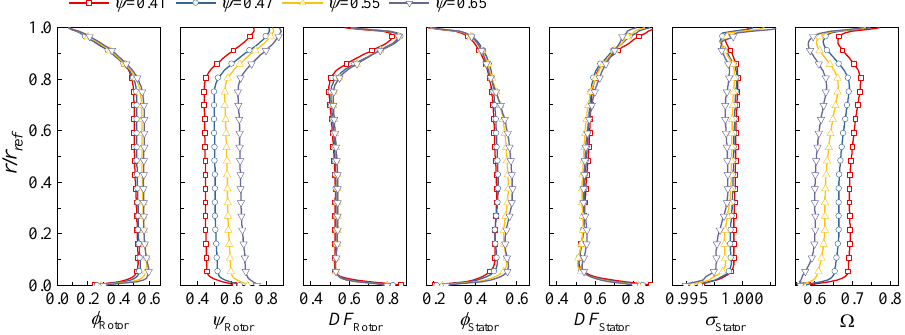
Figure 13. Spanwise aerodynamic performance for different compressor stages: near-stall point.